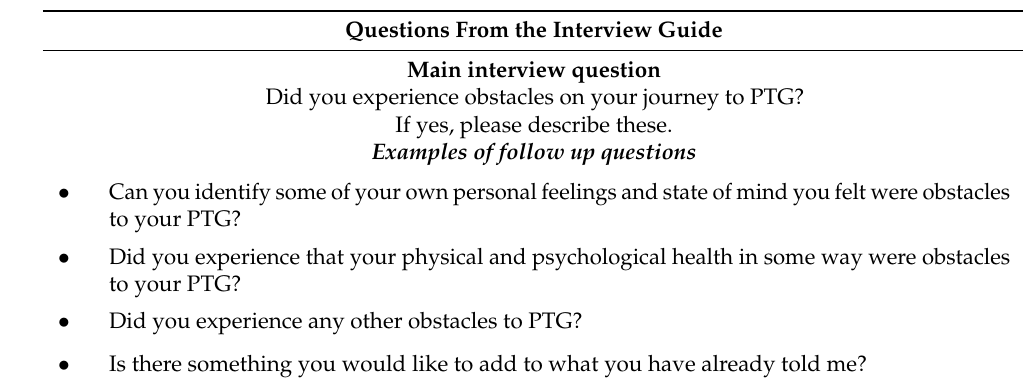
Table 3. Examples of questions from the interview guide used in this